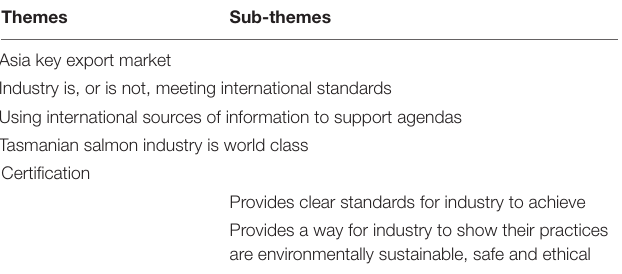
TABLE 3 | Themes from news